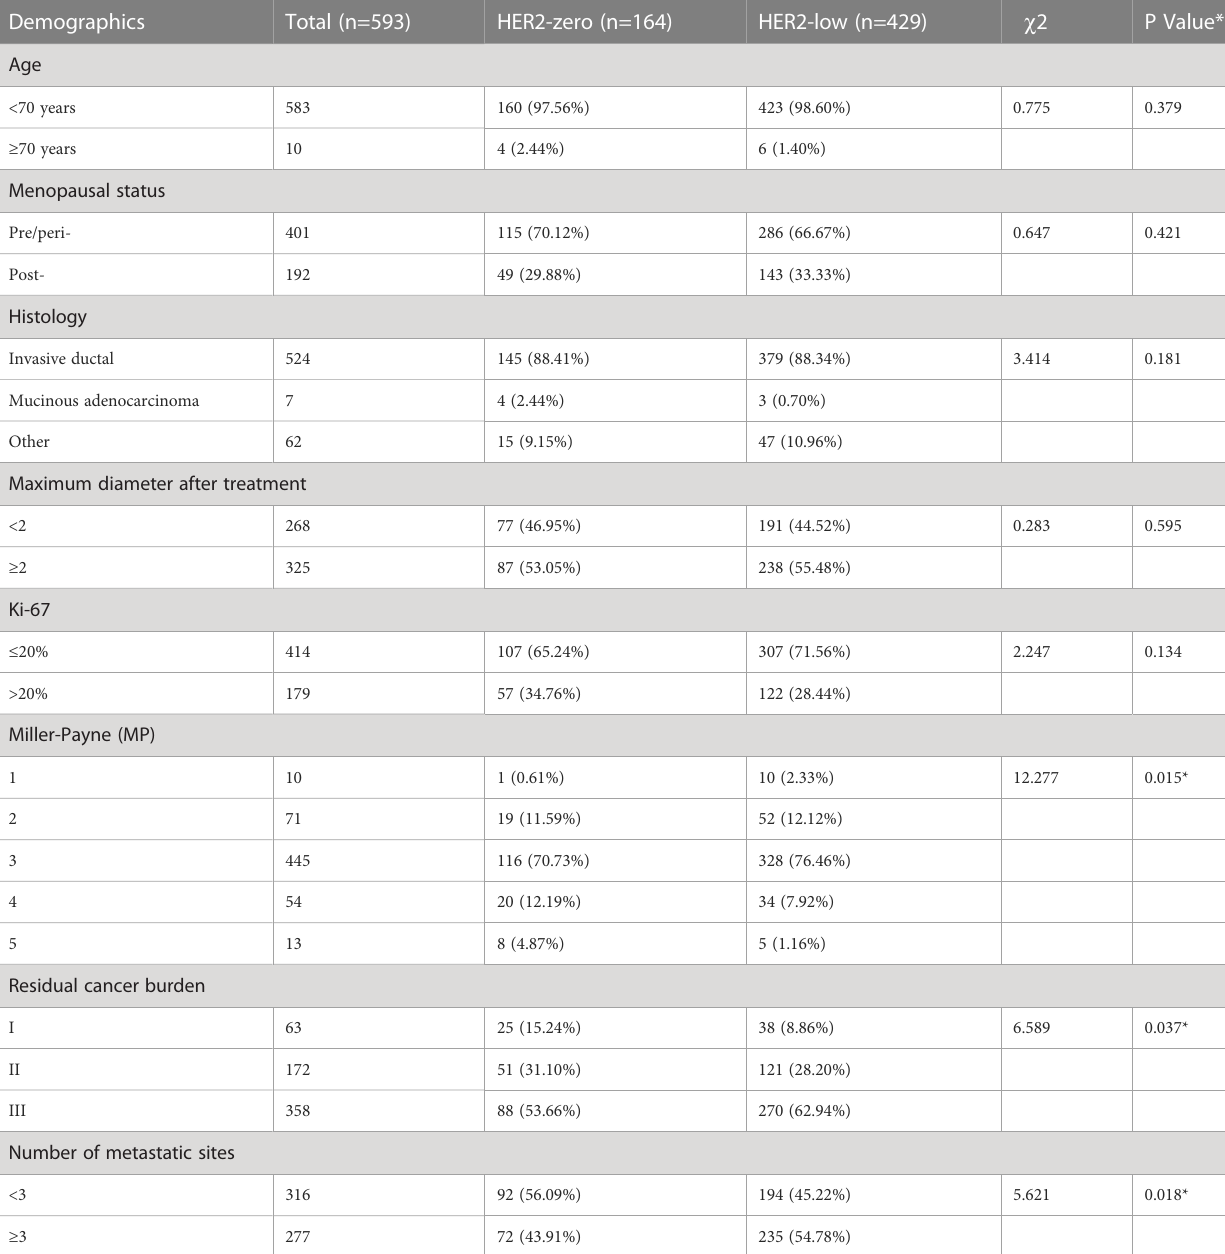
TABLE 6 Baseline patient characteristics strati fi ed by breast residual HER2 status (HER2 0 vs.